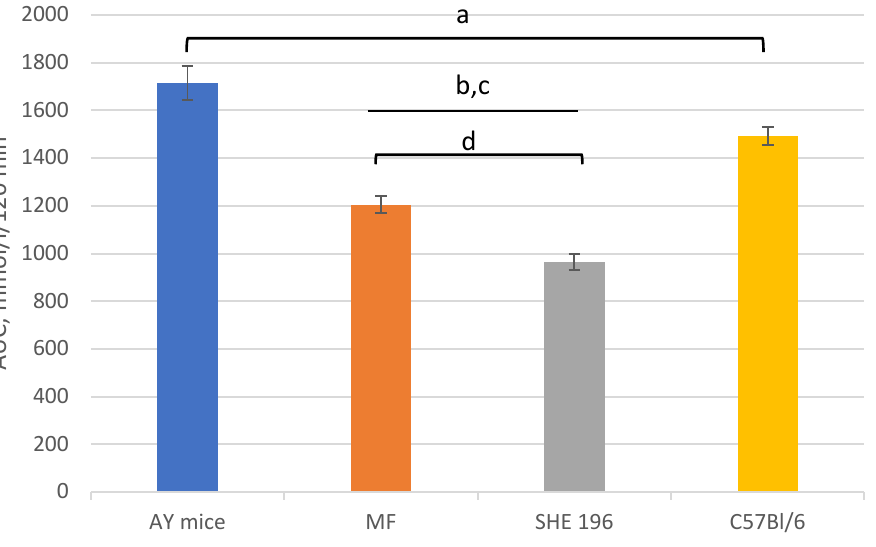
Figure 7. Area under the glycemic curve calculated according to the OGTT data after 2 weeks of AY mice treatment by SHE-196 at a dose of 15 mg/kg and MF at a dose of 250 mg/kg. a, b, c: p < 0.05 compared to AY mice; d: p < 0.05 compared to MF. Table 1. Mass of gonadal fat pads, interscapular fat pads and brown fat in AY mice treated for three weeks by SHE-196 at a dose of 15 mg/kg and MF at a dose of 250 mg/kg.